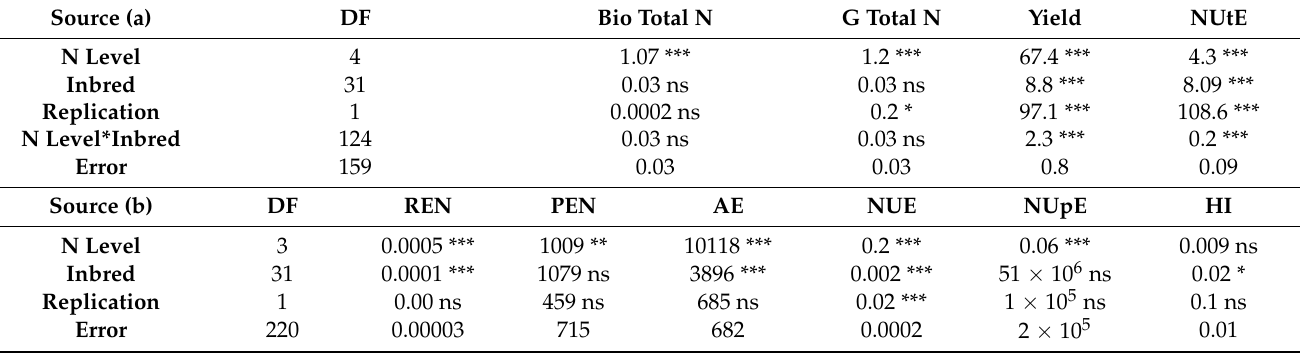
Table 2. Mean squares of parameters collected at various levels of nitrogen